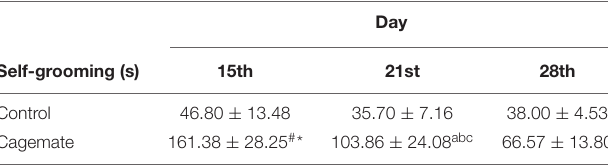
TABLE 6 | Self-grooming measured in three days during post-stress